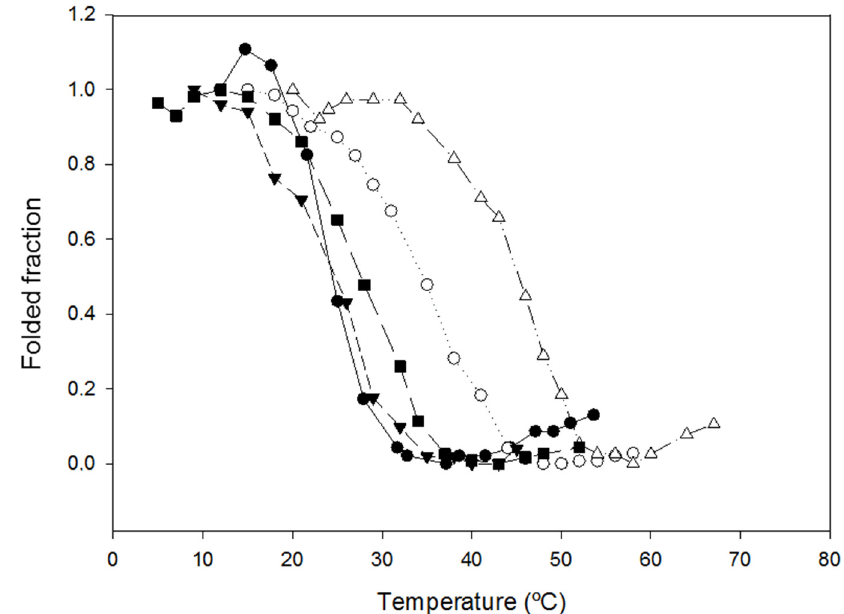
Figure 2. Temperature unfolding curves of the different variants in 1 M Gdm-Cl, 50 mM sodium acetate, pH 4.0. Symbols: NLSPE5 ( ); NLSPE5Cys1 ( ); NLSPE5Cys2 ( ▼ ); NLSPE5Cys3 ( Δ ); and NLSPE5Cys4 ( ). Curves were obtained monitoring the change in absorbance at 280 nm when the temperature was increased.